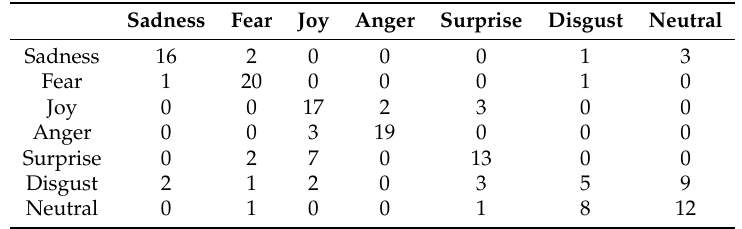
Table A2. P2 actor confusion matrix from the RekEmozio dataset in the second phase.